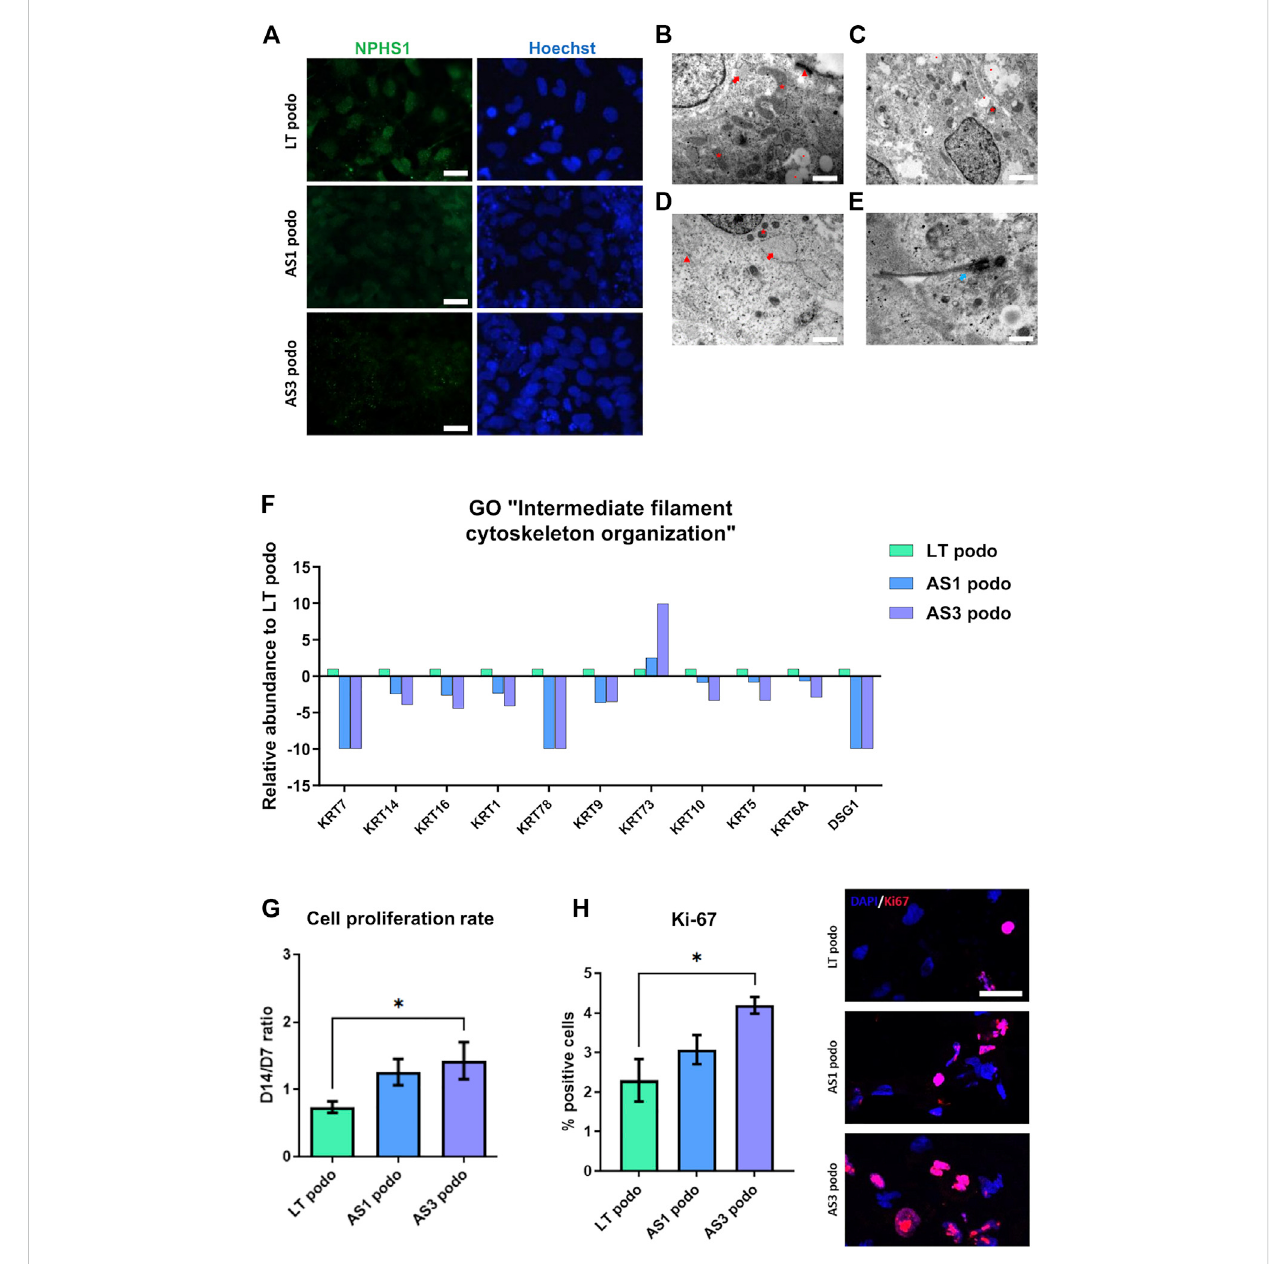
FIGURE 4 hiPSCs from Alport disease patients were differentiated into podocytes and compared with hiPSC-LT control podocytes. We observed weaker expression of NPHS1 by immuno fl uorescence in AS3 podocytes compared to AS1 and LT control, scale bar 50 µm (A) . (B) , electron micrograph of LT- differentiatedpodocytesshowingprominentnucleus, cytoplasmcontaininglarge mitochondria(asterisk),developing RER(arrow) withswollen cisternae and mature desmosomes (arrowhead), scale bar 200 nm. (C,D) , electron micrographs of AS1 and AS3 podocytes respectively, showing small mitochondria (asterisk), developing and prominent RER (arrow), immature desmosomes (arrowhead) and vacuoles (dot). Respectively, magni fi cation 120,00X,scalebar400 nmand25,000X,scalebar200 nm.Additionally,featureslikejunctionsanddesmosomes(redarrows)werelessmatureinAS1 (C) and AS3 (D) podocytes compared to LT controls. (E) , AS1 podocytes showing a primary cilium (white arrow), 40,000 X, scale bar 125 nm. In (F) , several keratins and Desmoglein 1 (DSG1), involved in epithelial maturation and desmosome formation were signi fi cantly decreased in Alport cell podocytes compared to LT podocytes control, as shown by the proteomics analysis. (G) , Alport cell lines remained in proliferation during day 7 to day 14 spheroid culture. (H) Quanti fi cationofKi-67positivecellsnormalizedovertotalnumberofcellsandexpressedin[%].Signi fi cancewastestedbyanunpaired t -test. Asterisk denotes statistically signi fi cant differences compared to AS3 podocytes, * p < 0.05. On the left Ki-67 expression by immuno fl uorescence. Scale bar 50